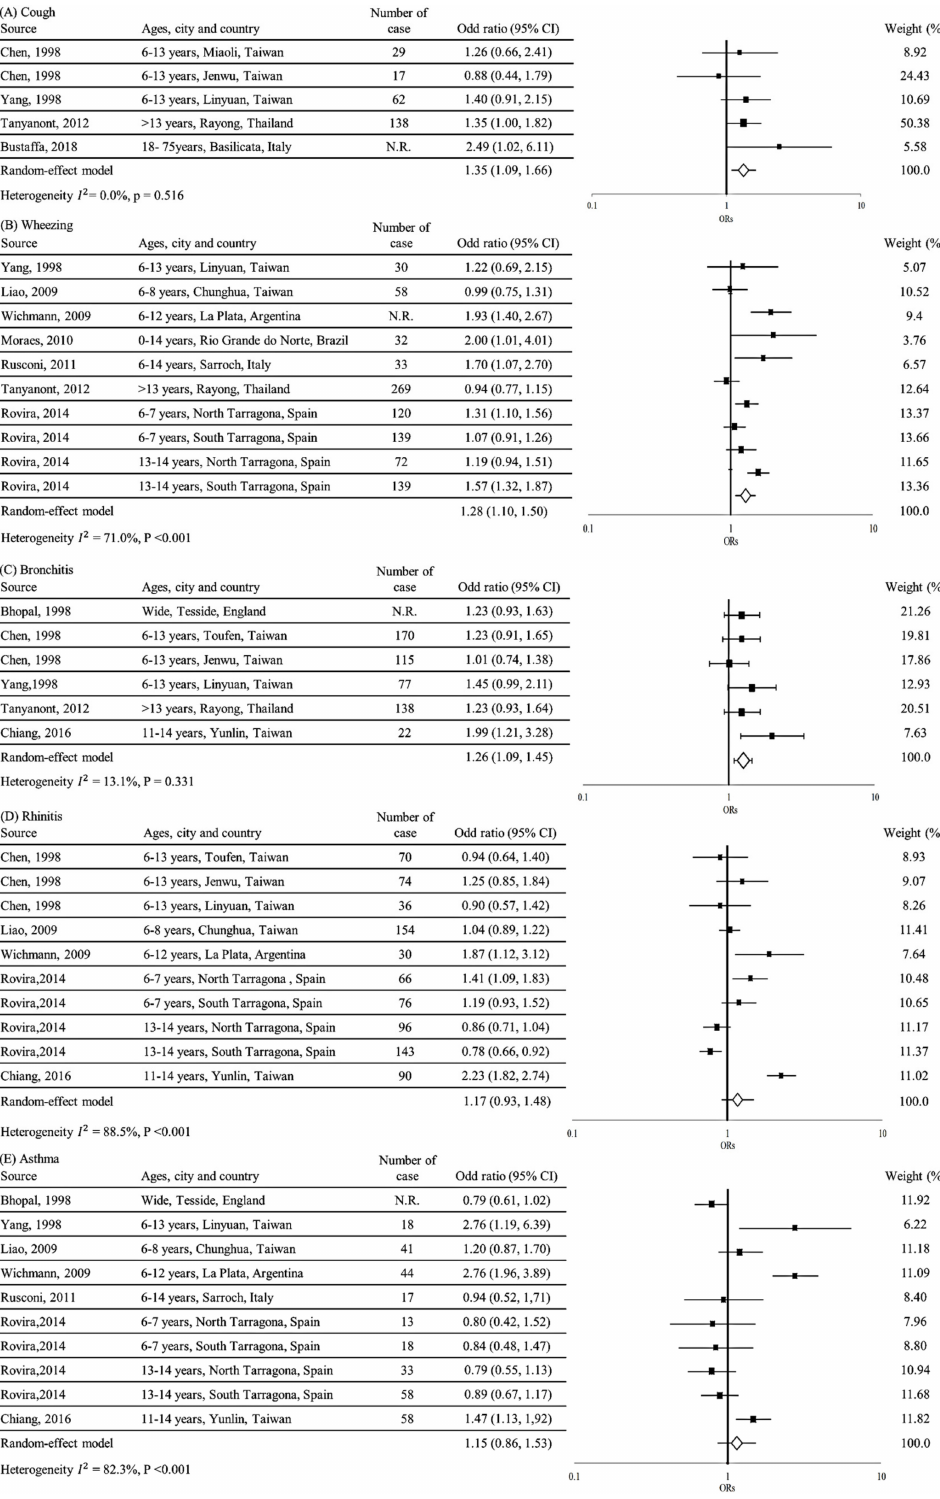
Figure 2. Forest plots of studies on five respiratory symptom risks among residents near petrochemical industrial complexes. ( A ) Forest plot of studies on cough; ( B ) forest plot of studies on wheezing; ( C ) forest plot of studies on bronchitis; ( D ) forest plot of studies on rhinitis; ( E ) forest plot of studies on asthma. N.R., nonreported; 95% CIs, 95% confidence intervals; Weight, the estimate for the study accounted for the weight